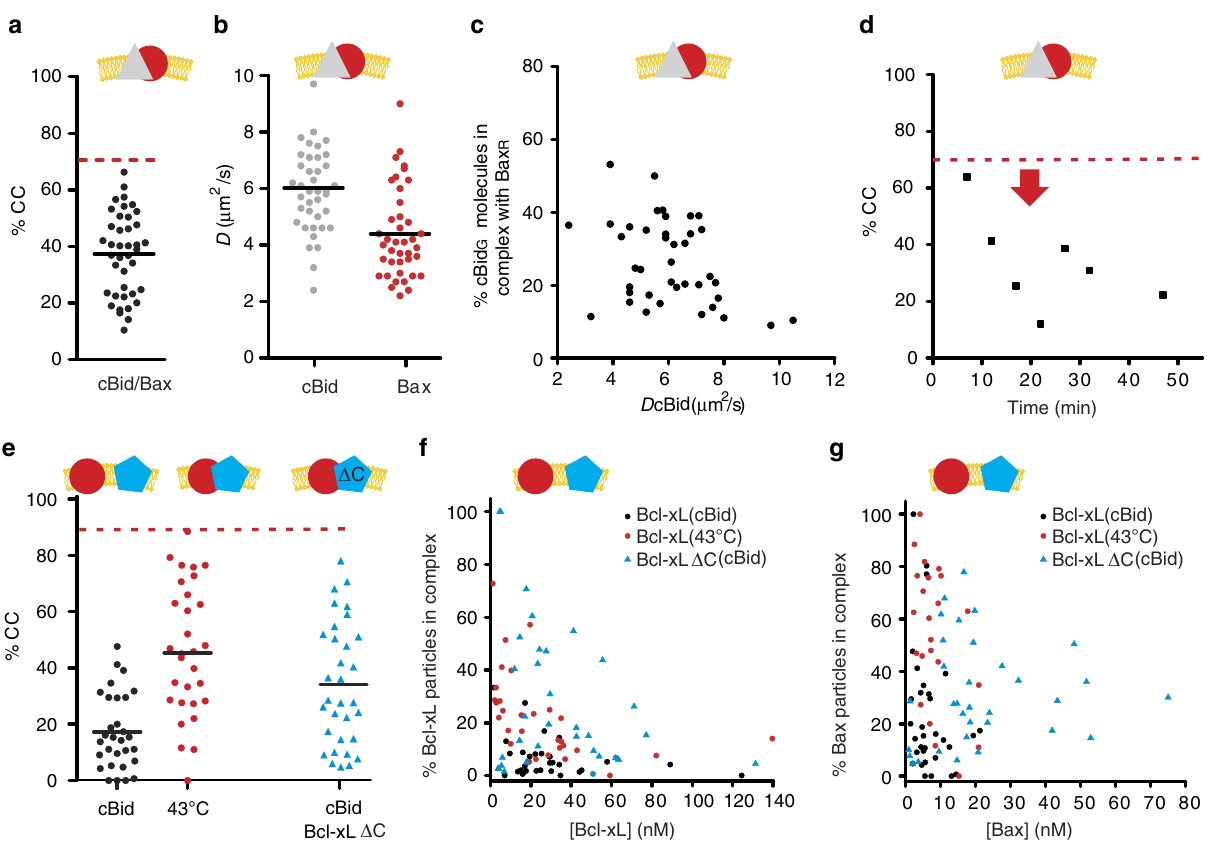
Fig. 6 Quantitative analysis of the interaction of Bax with cBid and Bcl-xL in membranes. a , b %CC ( a ) and D ( b ) of membrane-embedded cBid G and Bax R in individual GUVs (30% CL; n = 8). c Percentage of cBid G molecules in complex with Bax R vs. the D of cBid G in individual GUVs (30% CL; n = 8). d Temporal evolution of %CC between cBid G and Bax R in a single GUV. The red arrow marks the time point at which the GUV was permeabilized (see also Supplemental Fig. 9). e Comparison of %CC between membrane-embedded Bax R (90% labeled) and Bcl-xL G (100% labeled) or Bcl-xL Δ CT G (90% labeled) in individual GUVs (30% CL). Protein insertion into the membrane was activated by cBid or heat, as indicated ( n = 3). f Percentage of membrane- embedded Bcl-xL or Bcl-xL Δ CT molecules in complex with Bax in relation to the absolute concentration of Bcl-xL (after activation by cBid ( black dots ) or heat ( red dots )) or Bcl-xL Δ CT ( blue triangles ) ( n = 3). g Percentage of membrane-embedded Bax molecules in complex with Bcl-xL (after activation by cBid ( black dots ) or heat ( red dots )) or Bcl-xL Δ CT ( blue triangles ) in relation to the absolute concentration of Bax ( n = 3). The dotted red line in a , d , and e indicates the maximal possible CC considering the degree of labeling and dimer formation ( n = 3). e – g Experiments done with one protein batch so that